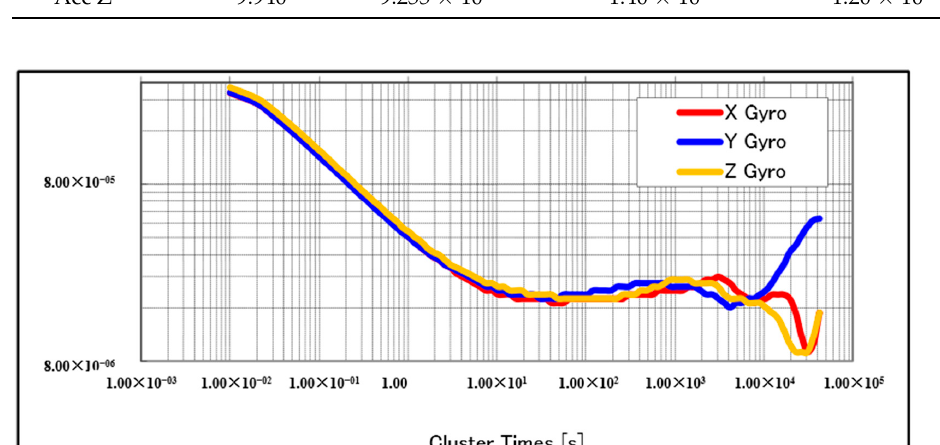
Figure 4. Allan variance (AV) plots for gyroscopes.